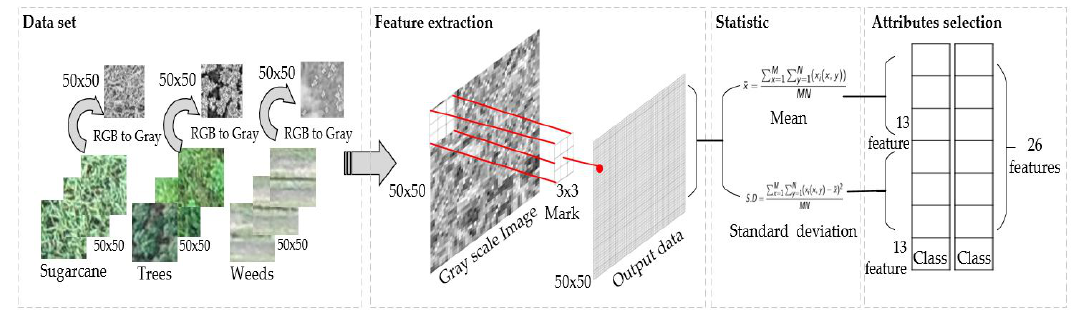
Figure 7. The conceptual framework of feature